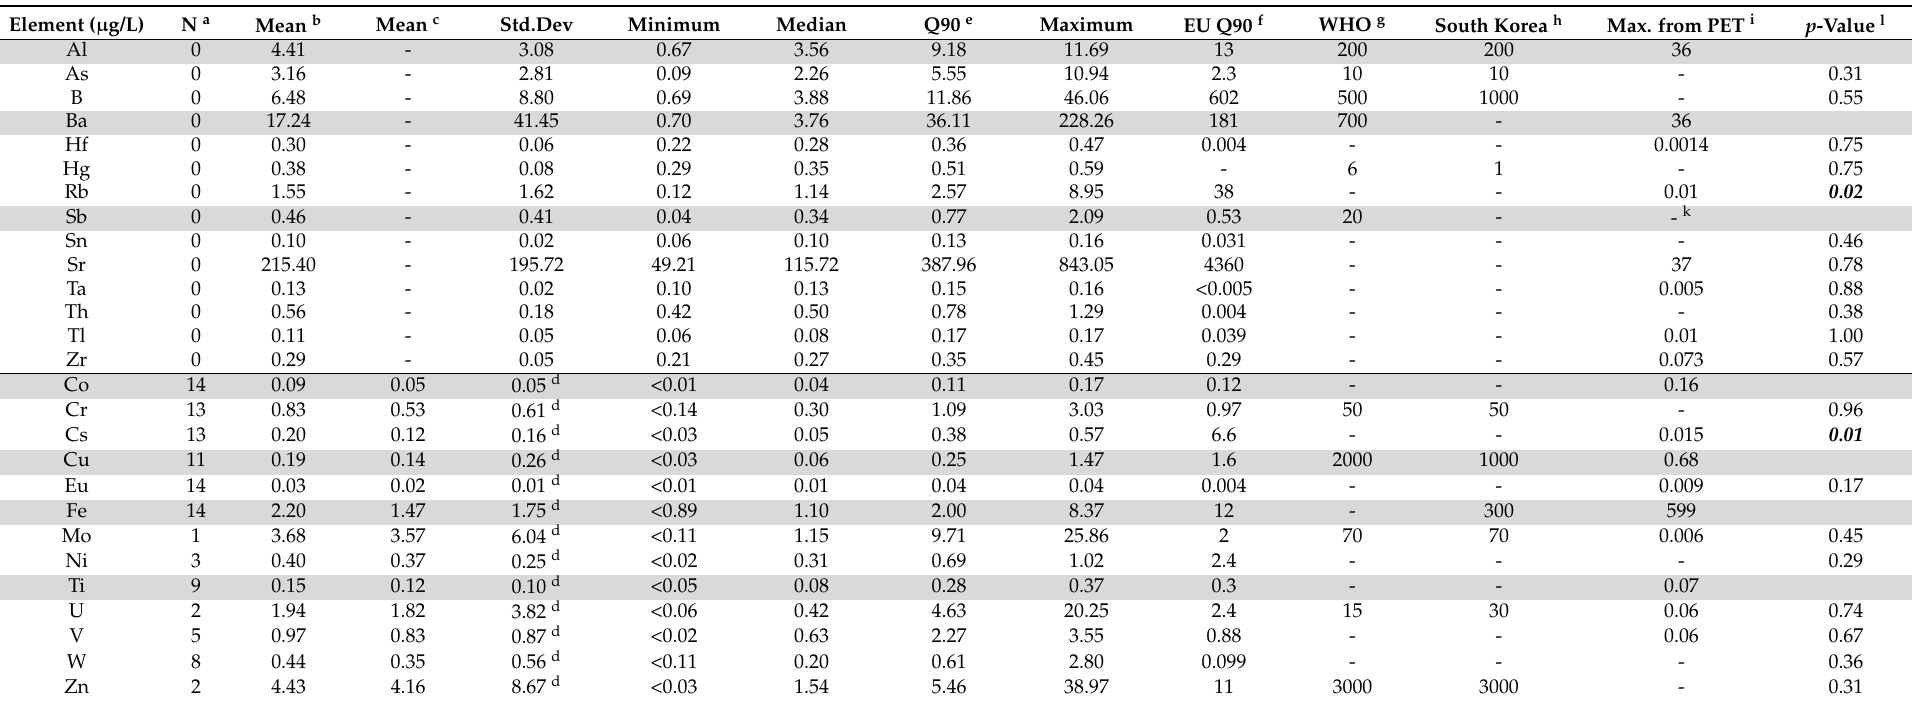
Table 3. Statistical summary of 27 trace elements in South Korean Ca-HCO 3 -type bottled mineral waters ( n = 33). WHO and South Korean drinking water quality standards are also shown. Seven, gray-shaded elements were excluded from further interpretation as their median concentrations were lower or similar to the maximum concentration level leachable from PET